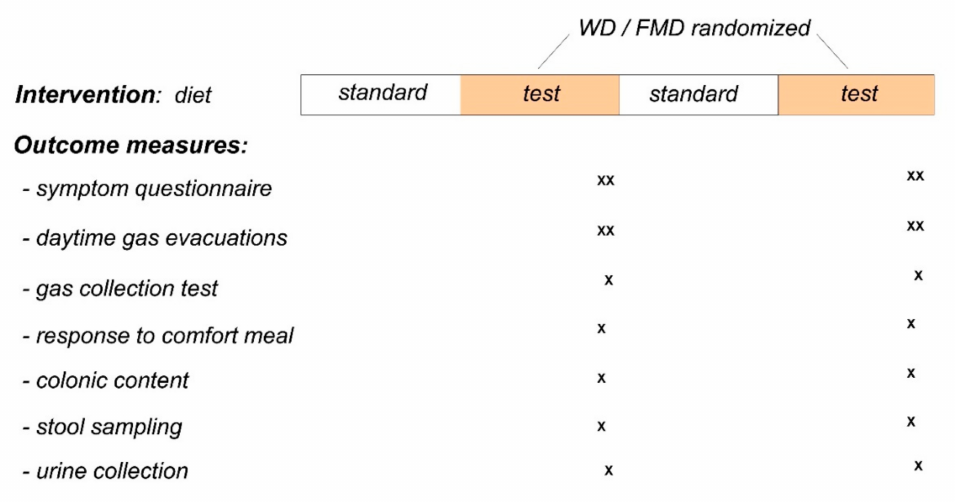
Figure 1. Experimental design. Cross-over, randomised study; 20 participants were included and 18 adhered to study instructions and were included for